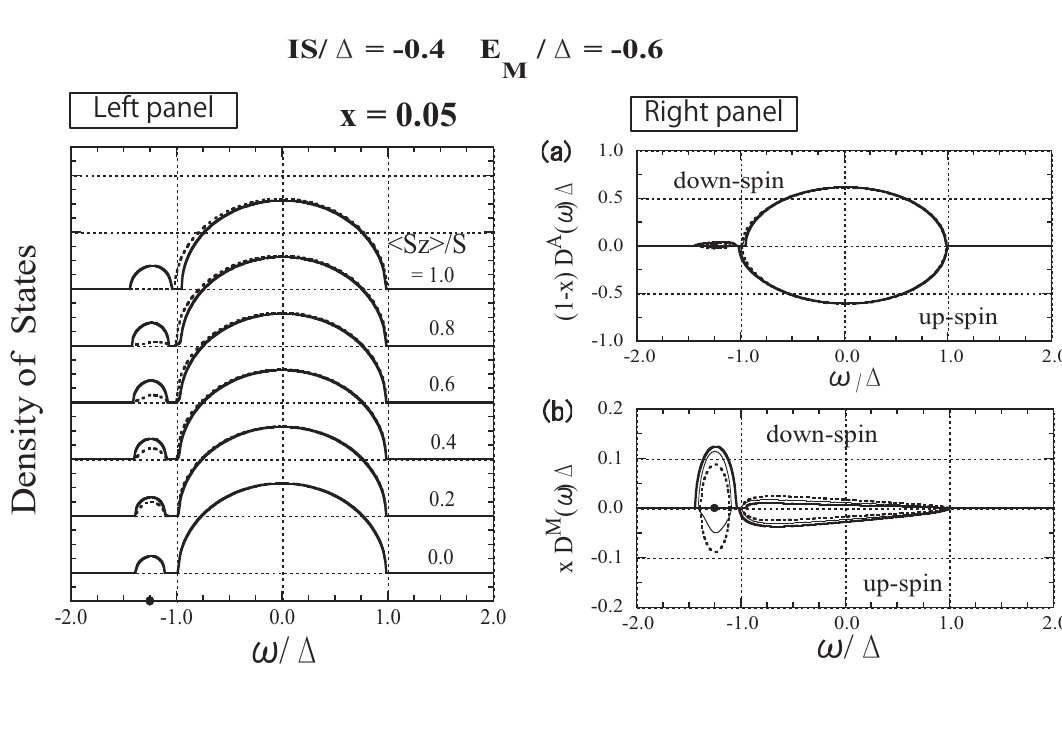
Figure 8. The results for the DMSs with strong attractive potential. Left panel: ⟩ =S . The solid lines represent DOS as a function of != ∆ for various values of ⟨ S z the down-spin carrier and the dotted lines represent the up-spin carrier. The = − 1 : 25∆ is indicated by the dot on the abscissa. Right impurity level E a ( ! )∆ , ( ! )∆ and − (1 − x ) D A panel: (a) A -site component of the DOS, (1 − x ) D A ↓ ↑ ( ! )∆ and − xD M ( ! )∆ . The thick, thin, (b) M -site component of the DOS, xD M ↑ ↓ ⟩ =S = 1 : 0 , 0 : 5 , and 0 : 0 , respectively. and dotted lines represent the cases of ⟨ S z From Takahashi and Kubo [42]. IS/ (cid:1063) = -0.4 E / (cid:1063) = M